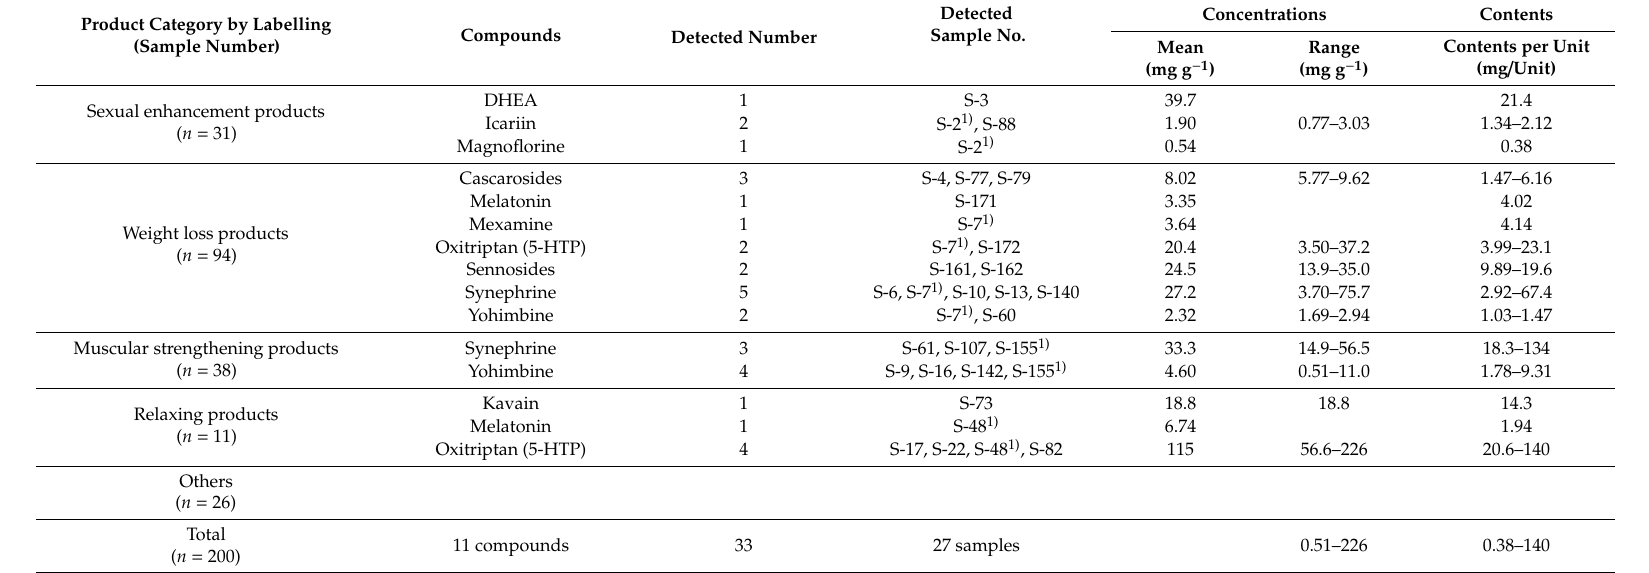
Table 3. Detected numbers and concentrations in dietary supplements by product